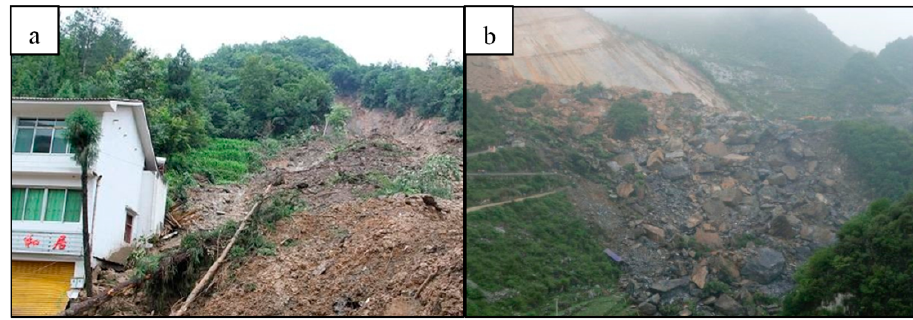
Figure 4. ( a ) Landslide in Qingchuan County, Sichuan; ( b ) Landslide in Nayong County, Guizhou.